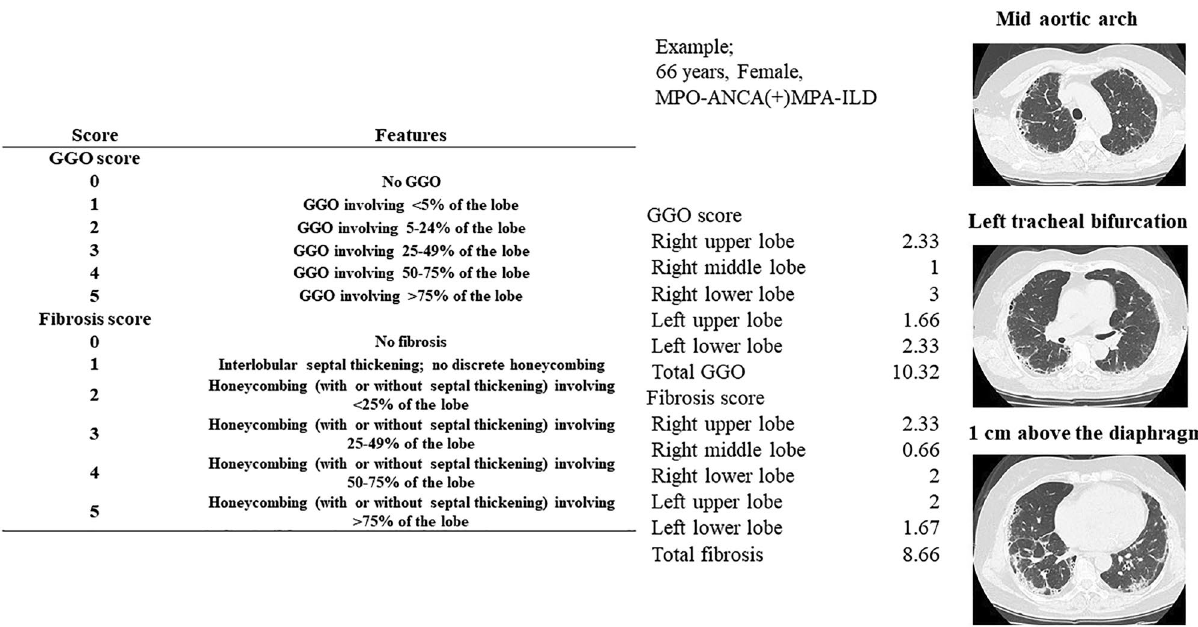
Figure 1. Chest HRCT scoring system using limited 3 CT levels; based on Kazerooni et al. 14 . Example: an example case of a 66-year old female with myeloperoxidase (MPO)-anti-neutrophil cytoplasmic antibody (ANCA)-positive microscopic polyangiitis (MPA) complicated by interstitial lung disease (ILD). GGO ground- glass